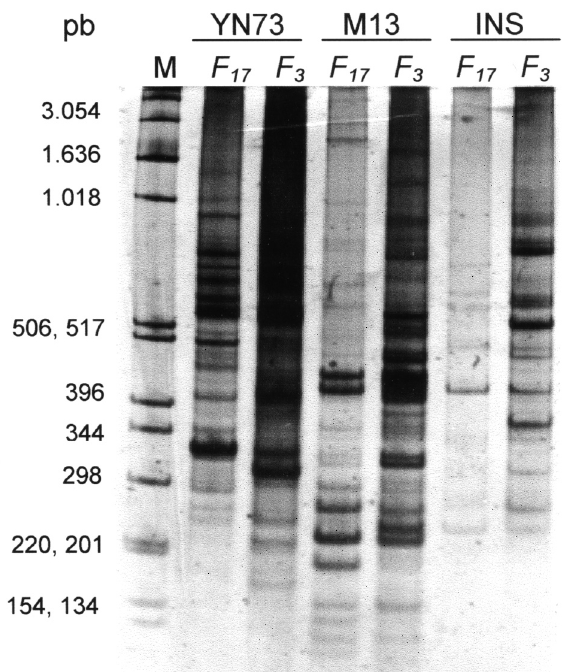
Figure 1 - Multiloci profiles obtained with the VNTR primers M13, YN73 and INS in two strains (F 3 Panama and F 17 Venezuela) of L. vannamei .